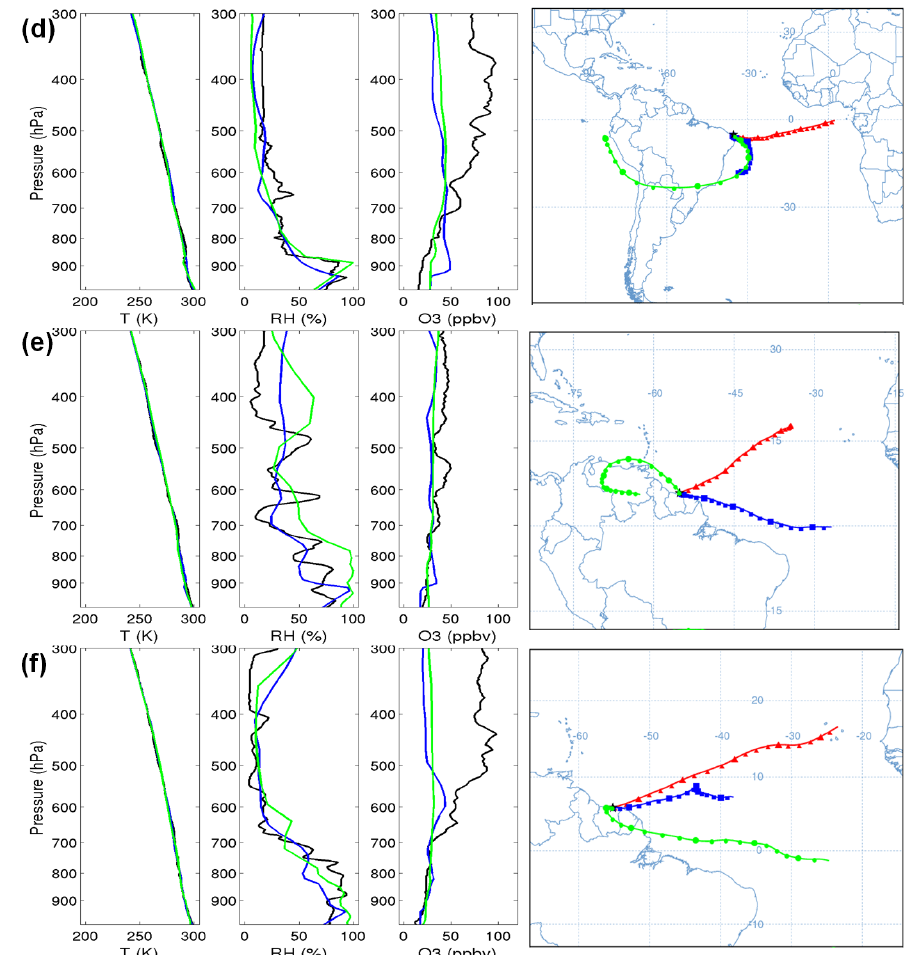
Figure 22. Vertical profiles of potential temperature, relative humidity, and O 3 from SHADOZ soundings (black), CCATT-BRAMS (blue), and WRF-Chem (green) and HYSPLIT back trajectories at 13:00UTC at 1500m (circa 850hPa, red), 6000m (circa 470hPa, blue), and 9000m (circa 310hPa, green) for: Paramaribo on (a) 6 November and (b) 25 November 2008, Natal on (c) 7 November and (d) 19 November 2008, and Paramaribo on (e) 4 May and (f) 11 May